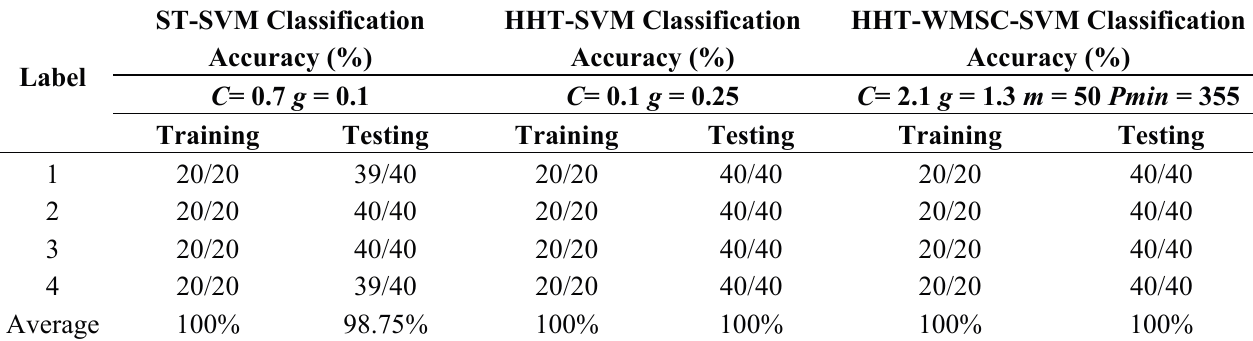
Table 4. Bearing fault detection results obtained by the ST-SVM, HHT-SVM and HHT-WMSC-SVM models for dataset